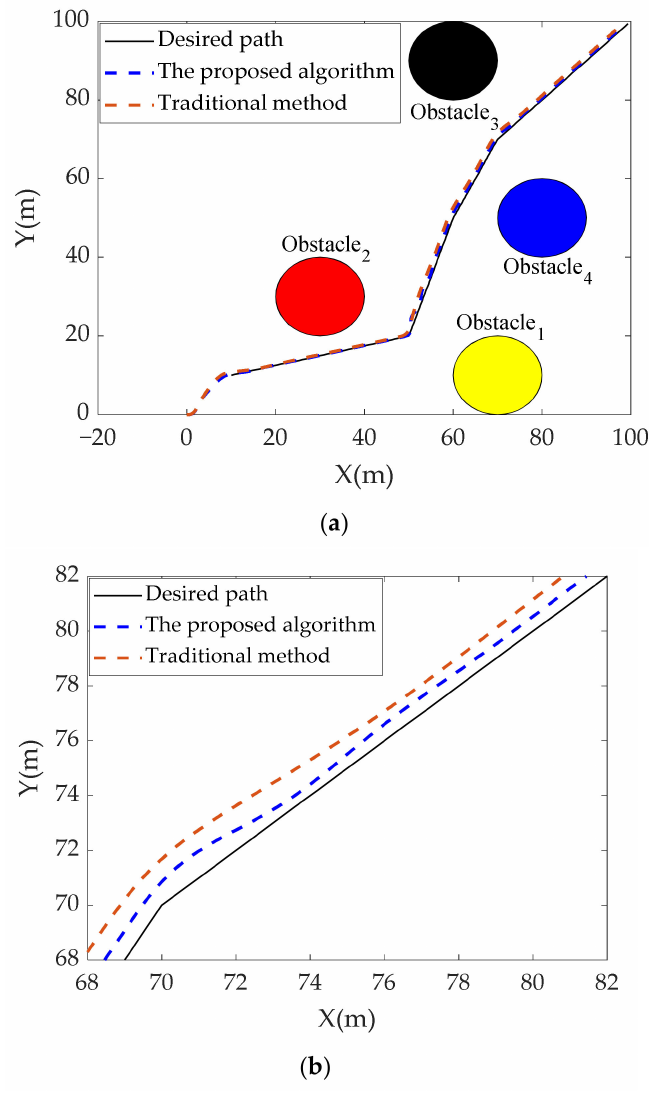
Figure 16. ( a ) Path tracking in the environment with obstacles. ( b ) Part of the enlarged view for path tracking curve.